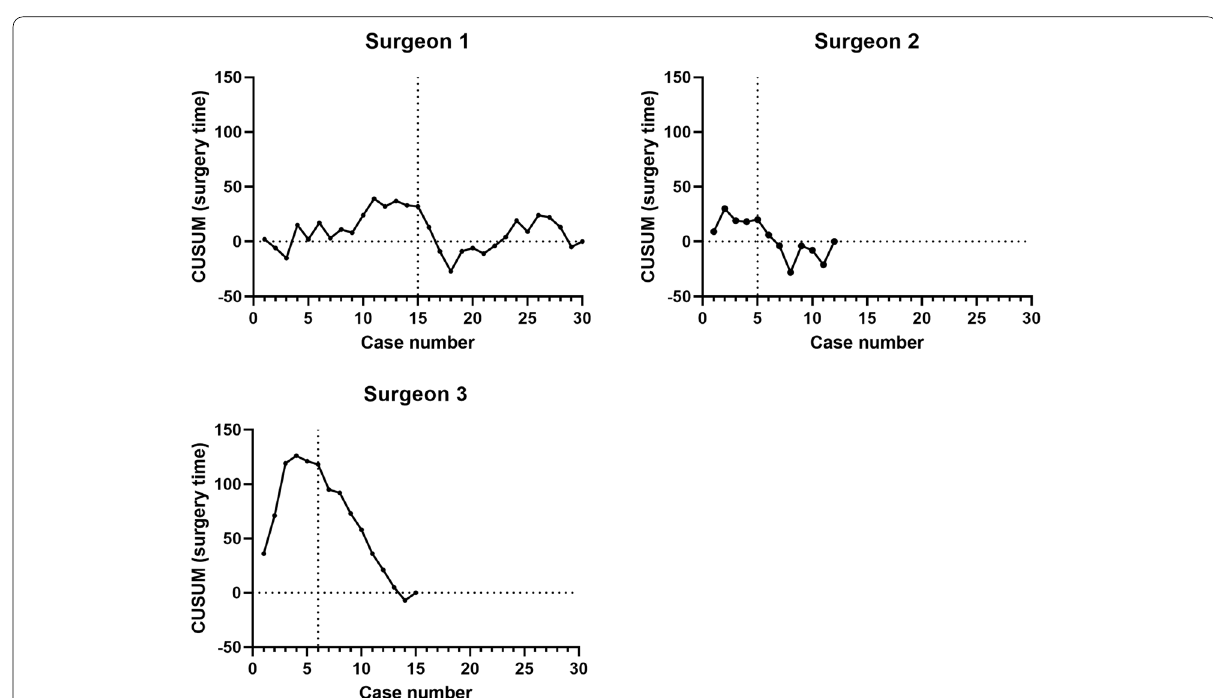
Fig. 1 Cumulative Summation (CUSUM) analysis of the initial RA total knee arthroplasty cases of three surgeons. Inflexion points were observed